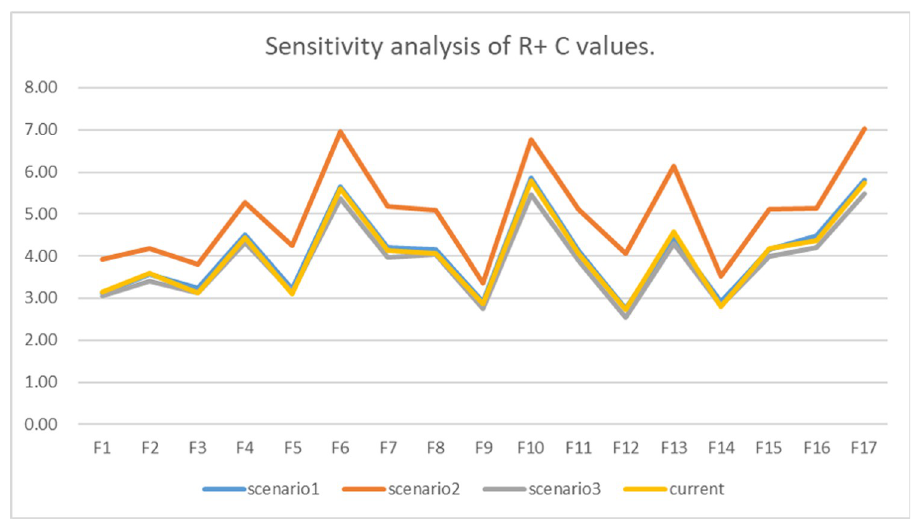
Fig 4. Sensitivity analysis of R+ C values.